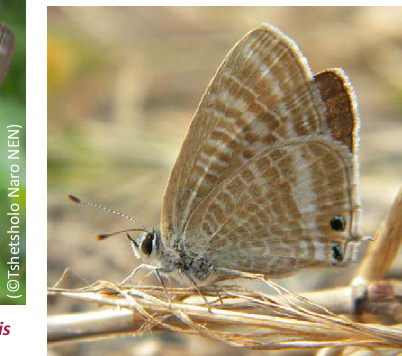
Image 46. Cerulean Jamides sp.